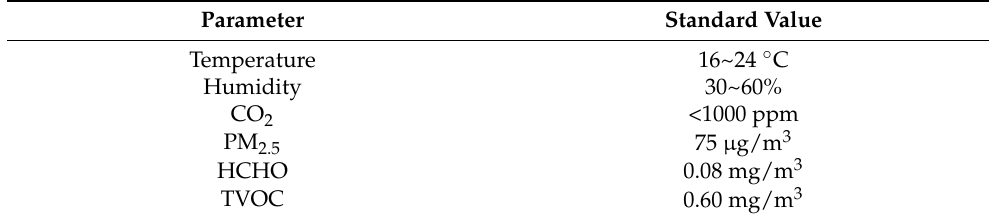
Table 4. IAQ standards in winter in